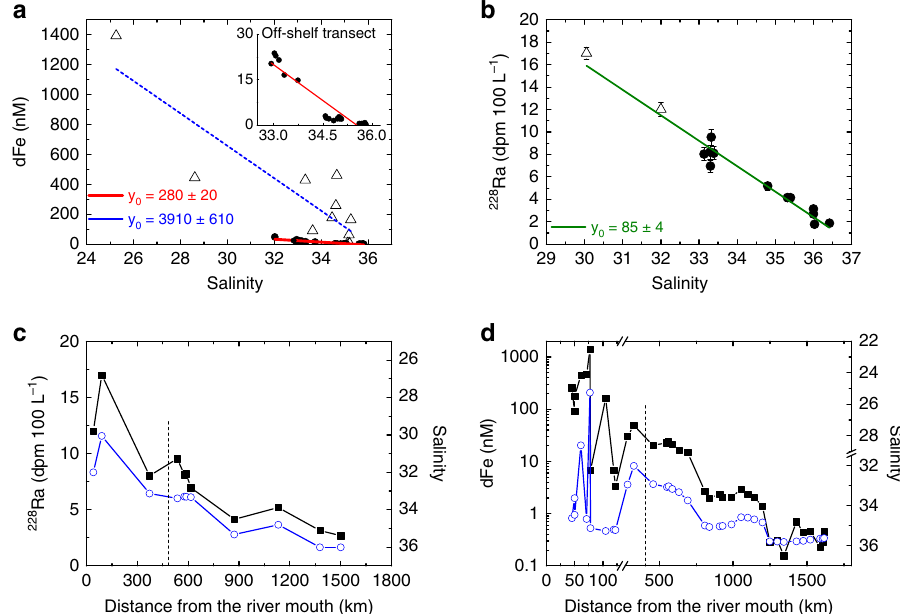
Fig. 2 Distributions of dFe, Ra and salinity in surface waters. Mixing diagram between river and open ocean waters from the Congo-shelf-zone to the end of the 3°S transect (stations 1202-1247) for dFe ( a ) and 228 Ra concentrations ( b ). Open triangles represent the samples collected in the Congo-shelf-zone and circles represent the samples in the off-shelf 3°S transect. Dashed blue line in a represents the regression line for the Congo-shelf-zone, and the red line represents linear regression for the off-shelf transect. Intercepts are represented as y 0 and considered as the effective-zero-salinity-endmembers. Inset in a is an expanded version of the off-shelf transect. The regression line for 228 Ra (green line in b ) includes all data. c , d 228 Ra, dFe (note log scale) (solid squares), and inverse salinity distributions (open circles) in plume surface waters from the Congo-shelf-zone to the end of the 3°S transect (stations 1202- 1247). Dashed vertical lines in c and d represent the beginning of the off-shelf transect at 3°S. Source data are provided as a Source Data fi le.